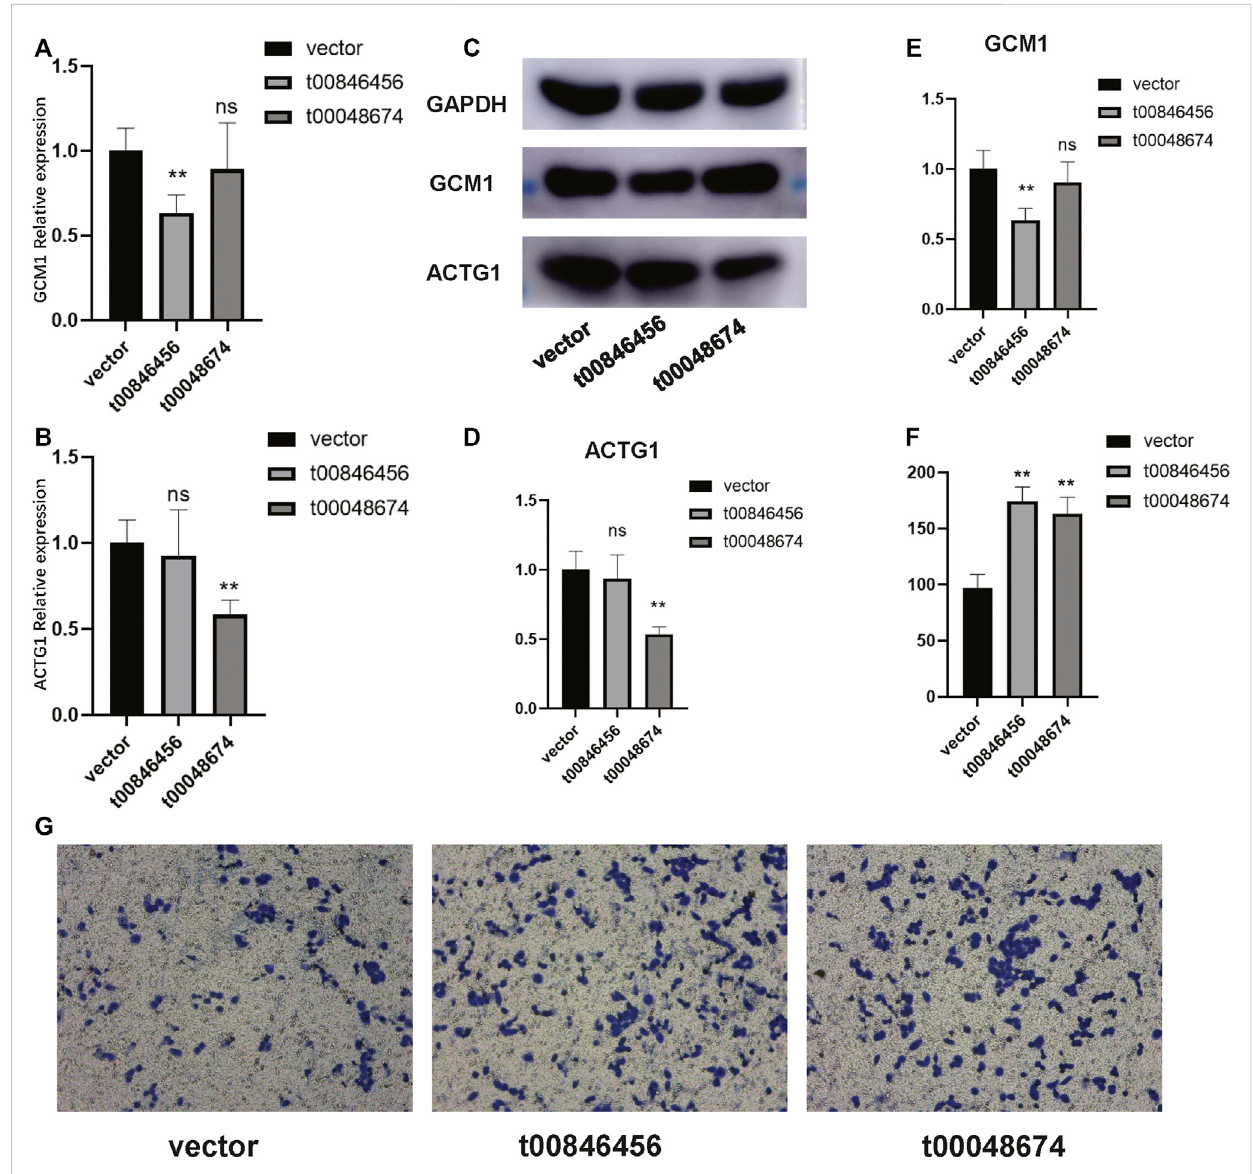
FIGURE 4 Validation of the experimentally con fi rmed target genes predicted from the bioinformatics analysis. (A) The expression of GCM1 signi fi cantly decreased after transfection with t0048674 knock down plasmid. (B) The expression of ACTG1 signi fi cantly decreased after transfection with t00846456 knock down plasmid. (C – E) Western blot results demonstrating that after transfection with t0048674 knock down plasmid, the corresponding ACTG1 protein was signi fi cantly decreased, and after transfection with t00846456 knock down plasmid, the corresponding GCM1 protein was signi fi cantly decreased. (F) A bar graph showing that the migration ability of cells transfected with over-expression of t00846456 and t0048674 signi fi cantly increased. (G) A trans well graph showing that the migration ability of cells signi fi cantly increased after transfection with over- expression of t00846456 and